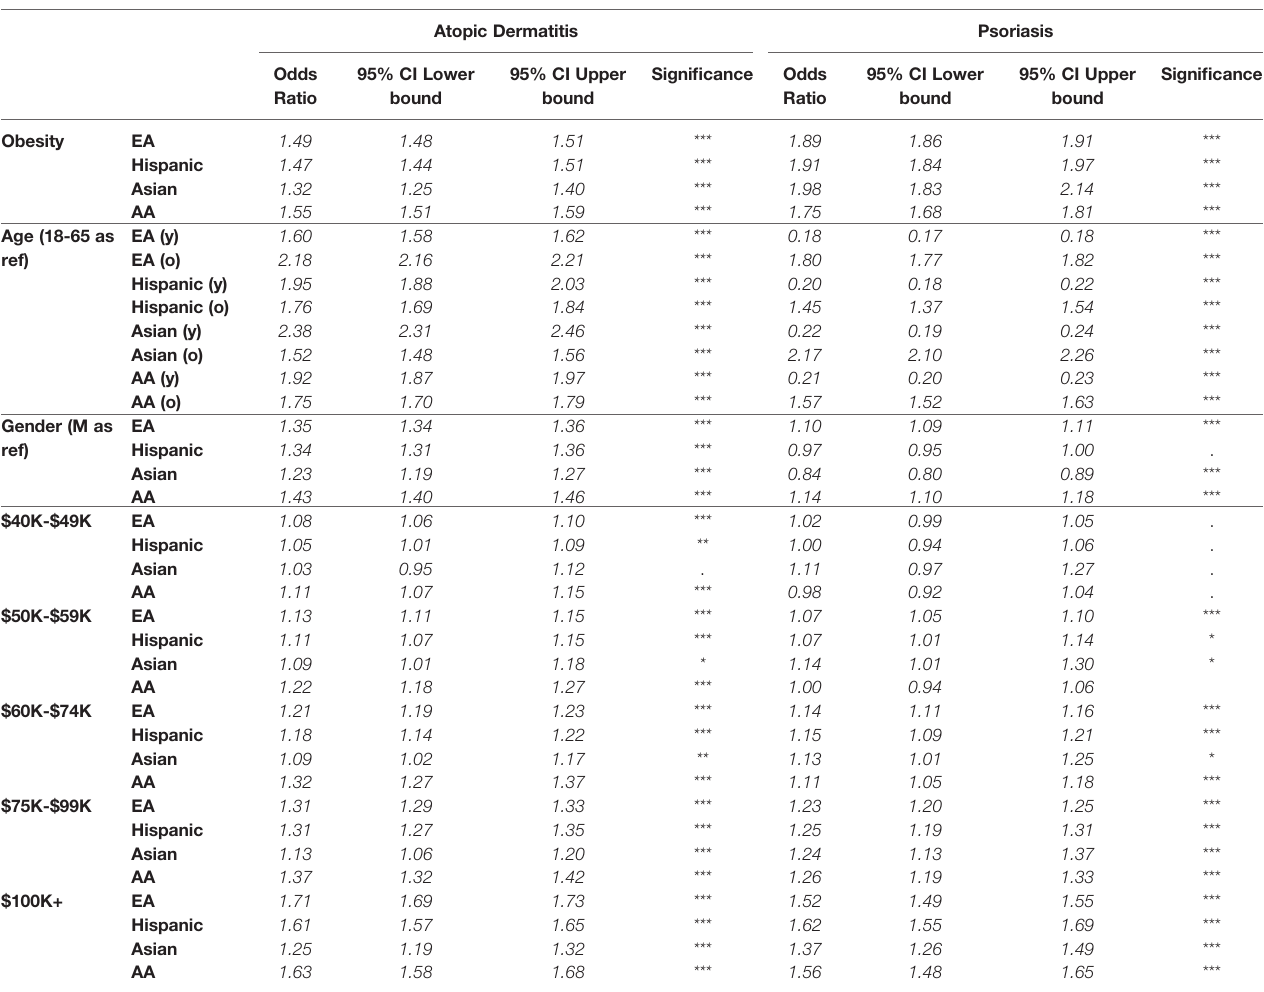
TABLE 1 | Risk factors for atopic dermatitis and psoriasis strati fi ed by different ethnic groups.